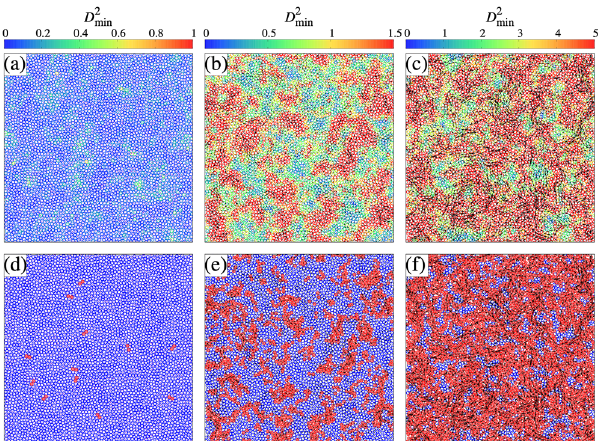
FIG. 3. Two-dimensional soft spheres. (a) – (c) Nonaffine dis- placements D 2 and (d) – (f) defects for three different configu- min rations. In (d) – (f), defects are shown in red, other particles are in t ¼ 0 Þ − r t → blue. In all panels, the displacement vectors r i ð i ð ∞ Þ (arrows) are amplified by a factor of 3. The temperature is T ¼ 0 . 035 in (a) and (d), 0.2 in (b) and (e), and 0.8 in (c) and